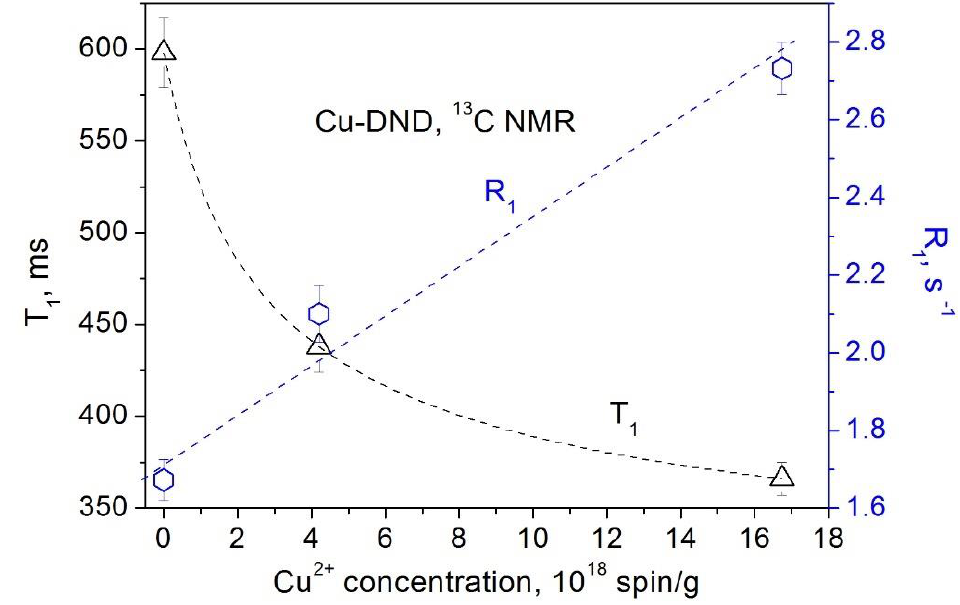
Figure 6. Dependence of the 13 C spin–lattice relaxation rate R 1 (circles) and the spin–lattice relaxation time T 1 (triangles) in Cu-DND powders on the Cu 2+ ion concentration.